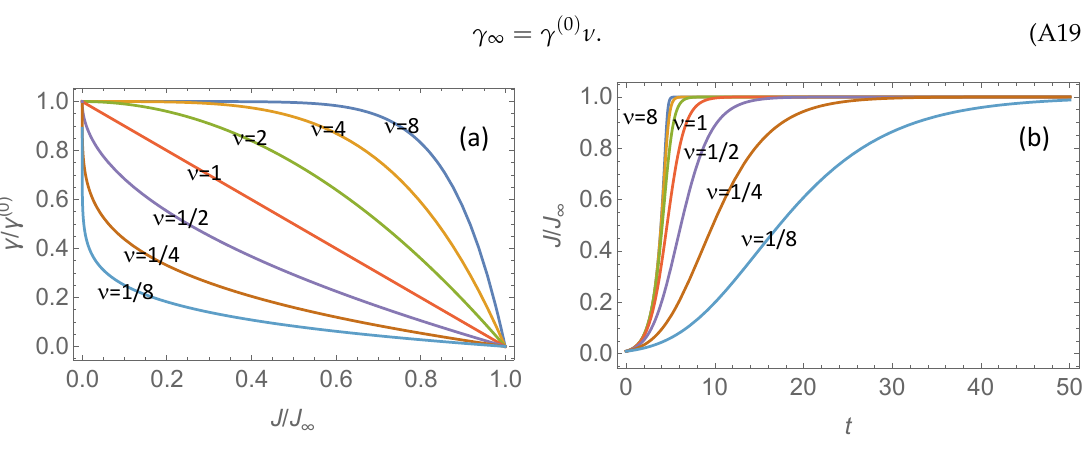
Figure A1. ( a ): Normalized growth rate γ / γ ( 0 ) as a function of J / J ∞ for varying ν . Light blue; ν = 1/8. Brown; ν = 1/4. Magenta; ν = 1/2. Red; ν = 1. Green; ν = 2. Orange; n = 4. Dark blue; ν = 8. For ν = 1 we have the symmetric logistic growth curve [11]. Increasing ν > 1 shifts the inflection point J s closer to the limiting value J ∞ . Decreasing ν < 1 shifts it towards J 0 . ( b ): Normalized Richards growth curve J / J ∞ as a function of time t for varying ν with same color coding as in